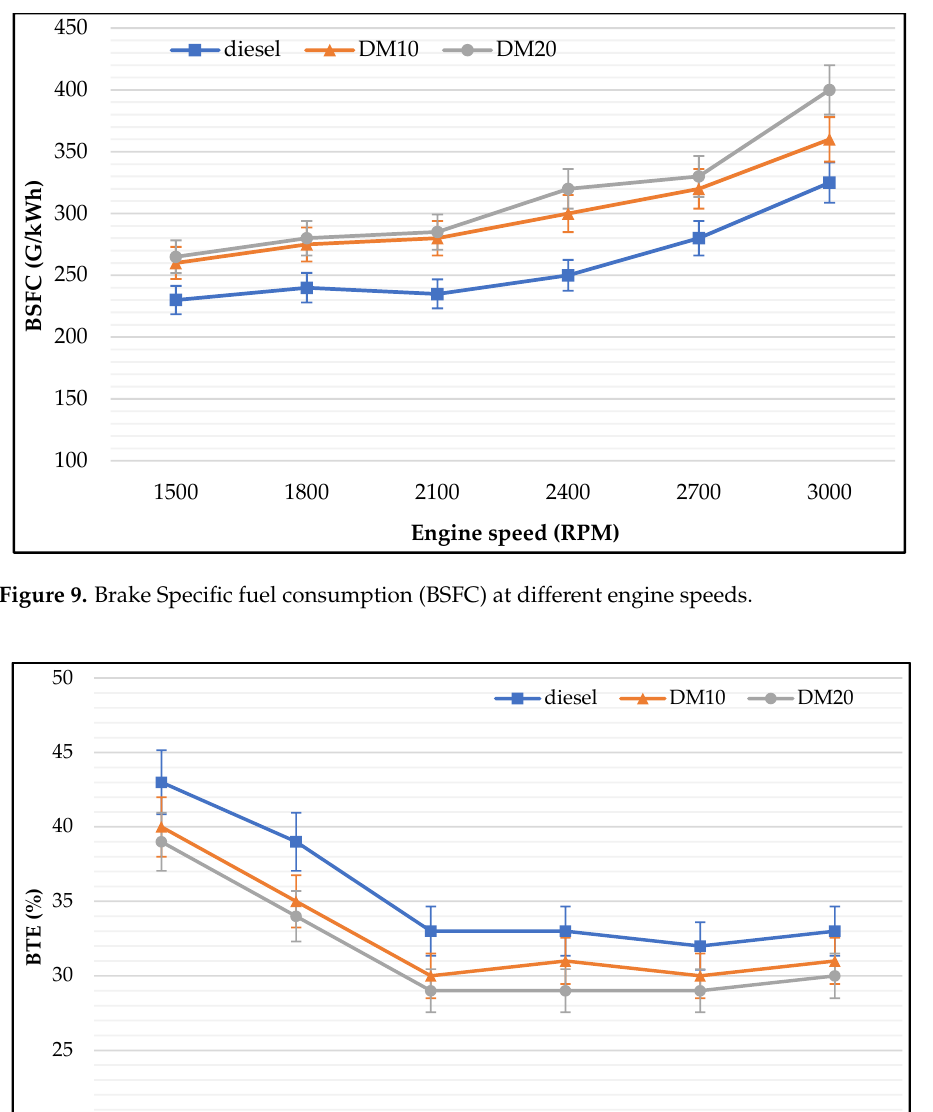
Figure 11. Engine torque, at different engine speeds. 3.2.4. Engine Brake Power Engine speeds strongly influence the engine BP, Figure 12. When using blended fuel, brake power increased by running the engine with higher speeds.